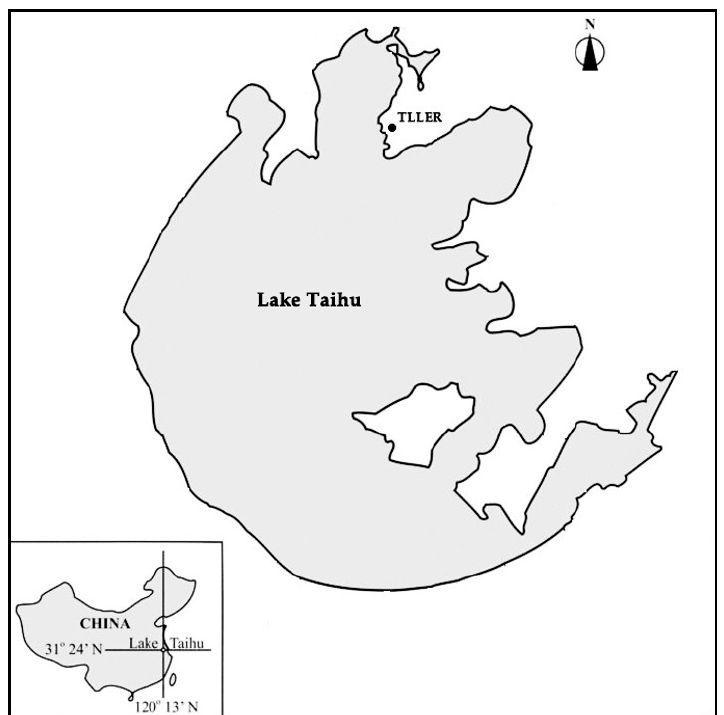
Figure 1. Location of Lake Taihu in China (the solid dot shows Taihu Lake Laboratory Ecosystem Research Station (TLLER) where the mesocosm experiment was conducted).